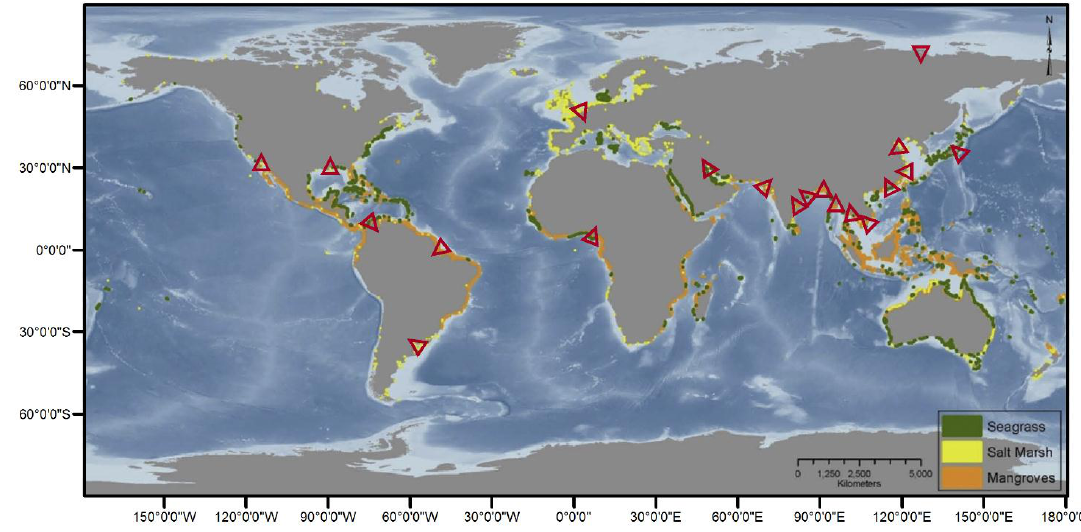
Figure 1. Global distribution of seagrass meadows, salt marshes, mangroves [2], and major deltas ( red triangles )